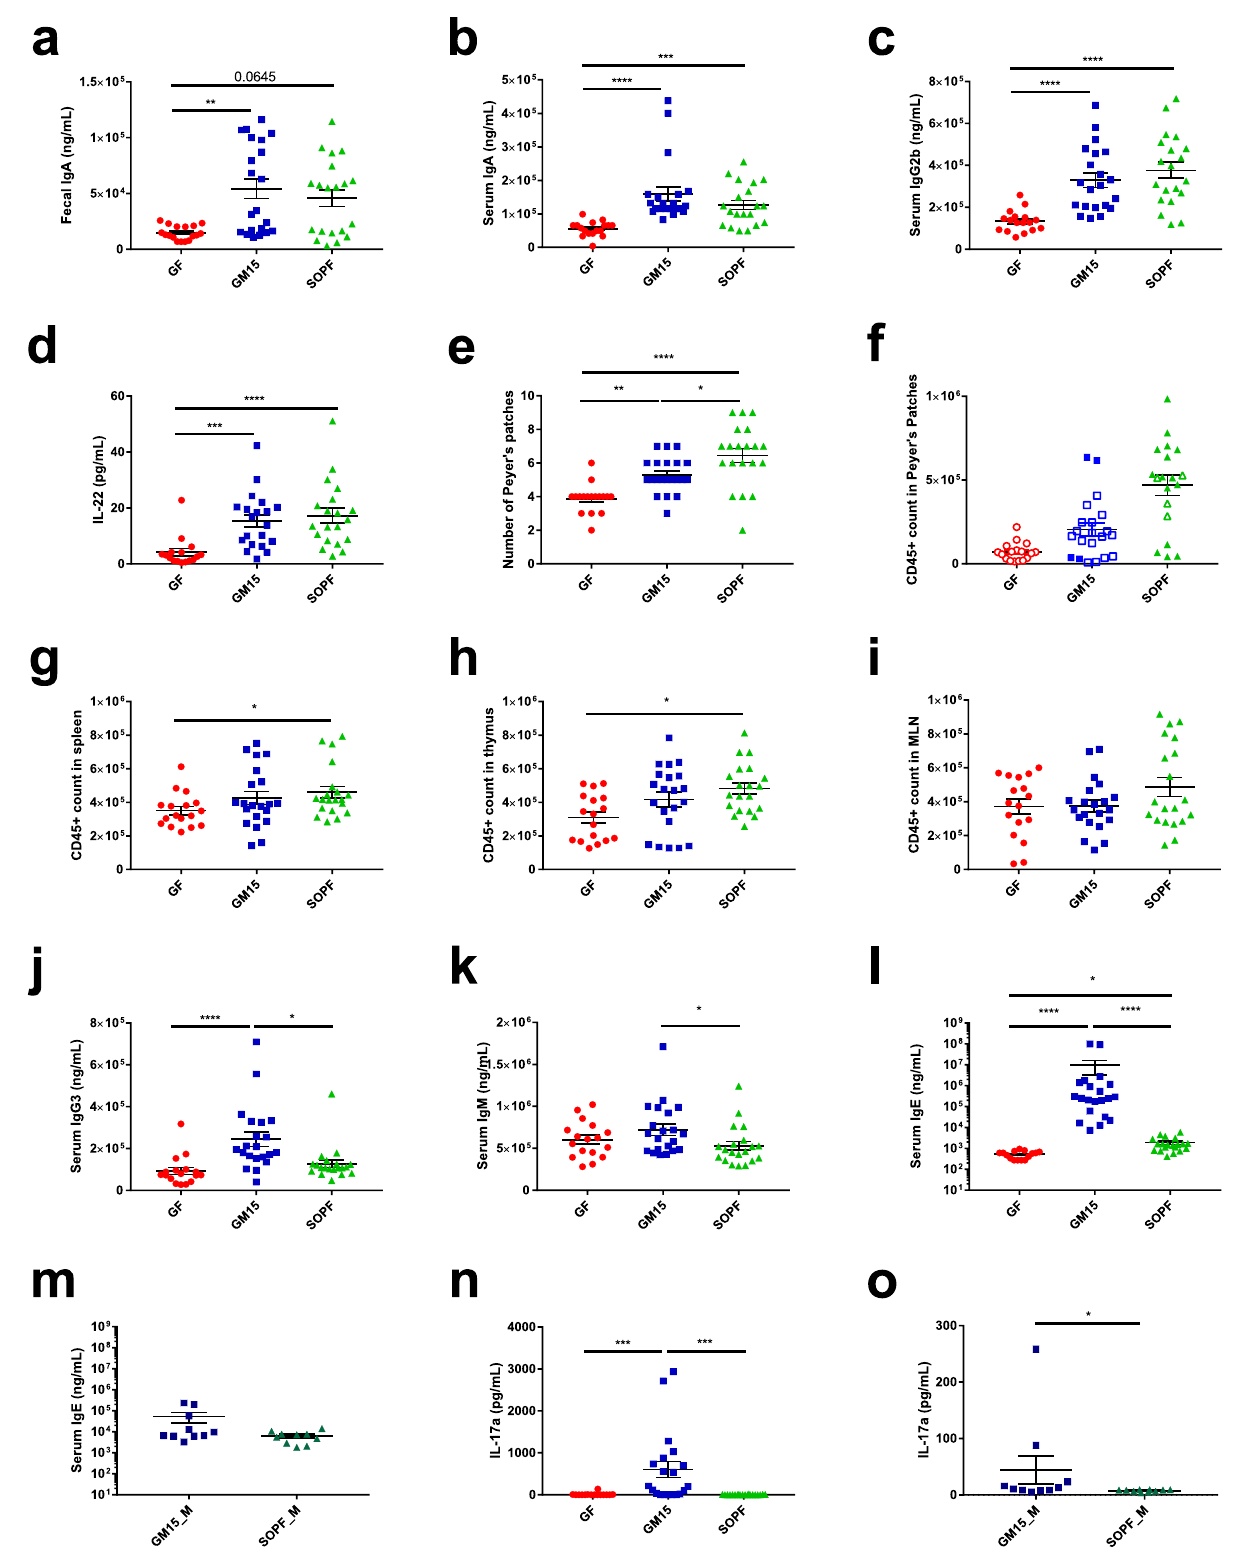
observed as well for some serum Ig levels. In our model, IgG3 levels were increased in GM15 mice compared to GF and SOPF mice and IgM levels were slightly increased in GM15 mice compared to SOPF (Fig. 4j, k). Of note, those Ig levels were lower in our SOPF mice than levels already described in SPF mice 47,48 .